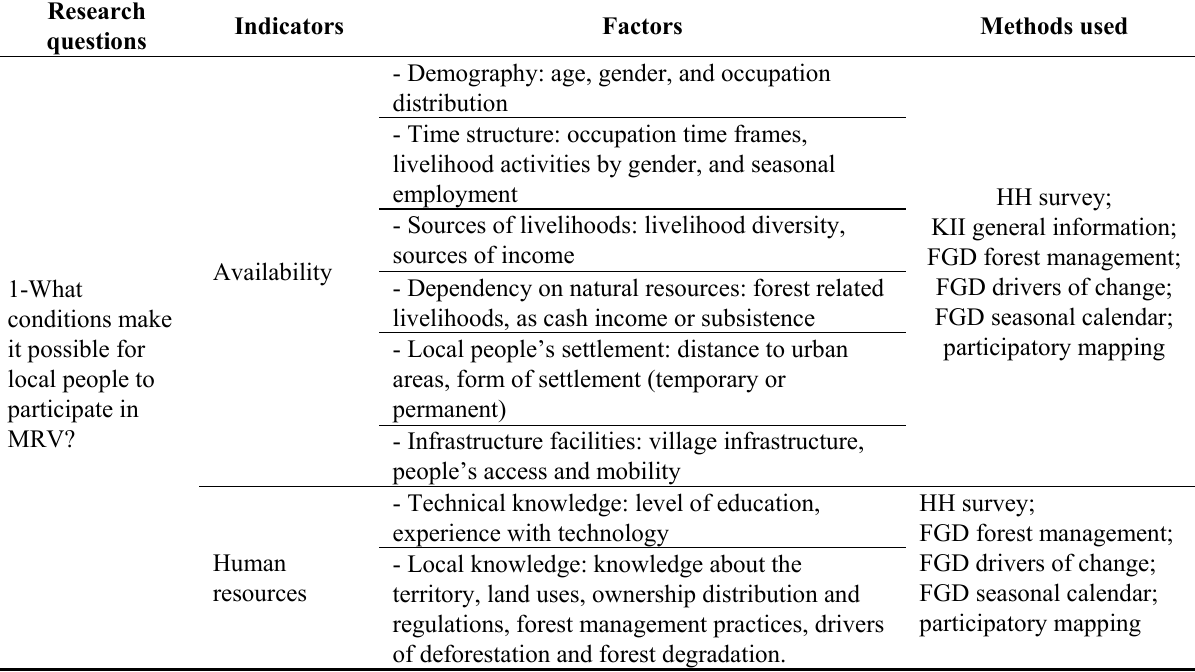
Table 3. Social science research design and the conditions for local participation in